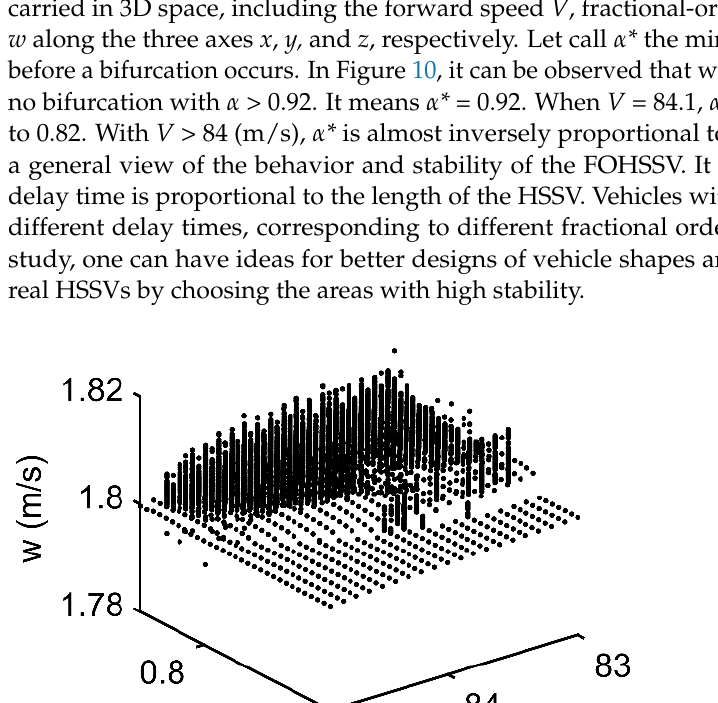
Figure 9. Bifurcation diagram of the FOM respecting to forward speed V ( α = 0.85).